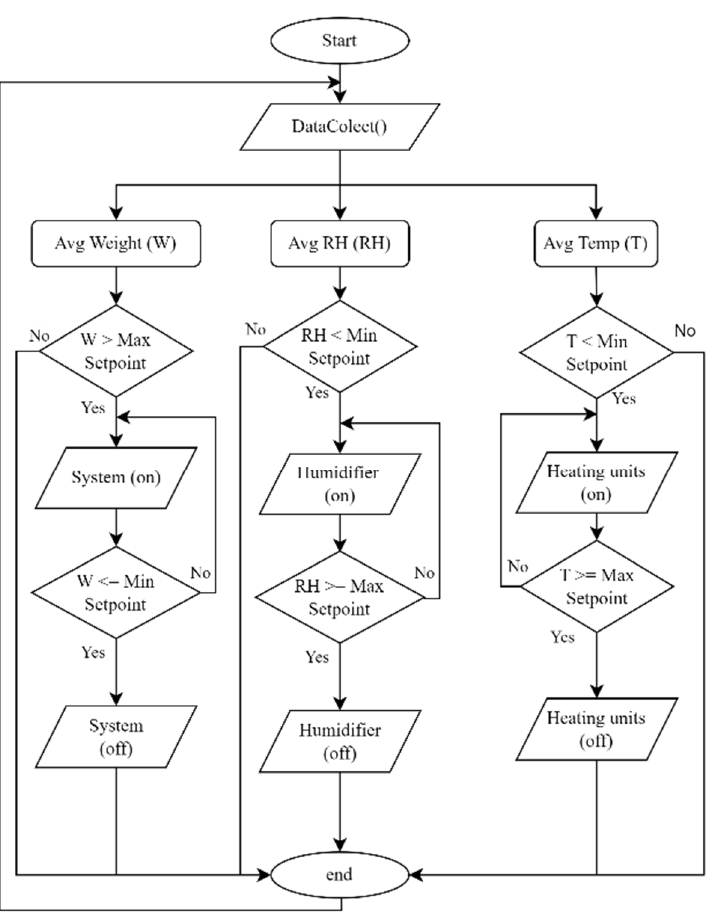
Figure 4. The control flowchart of the designed S-BARS. The Avg Temp (T) is the average temperature, the Avg RH is the average relative humidity, and the Avg Weight is the average weight of the fruit.